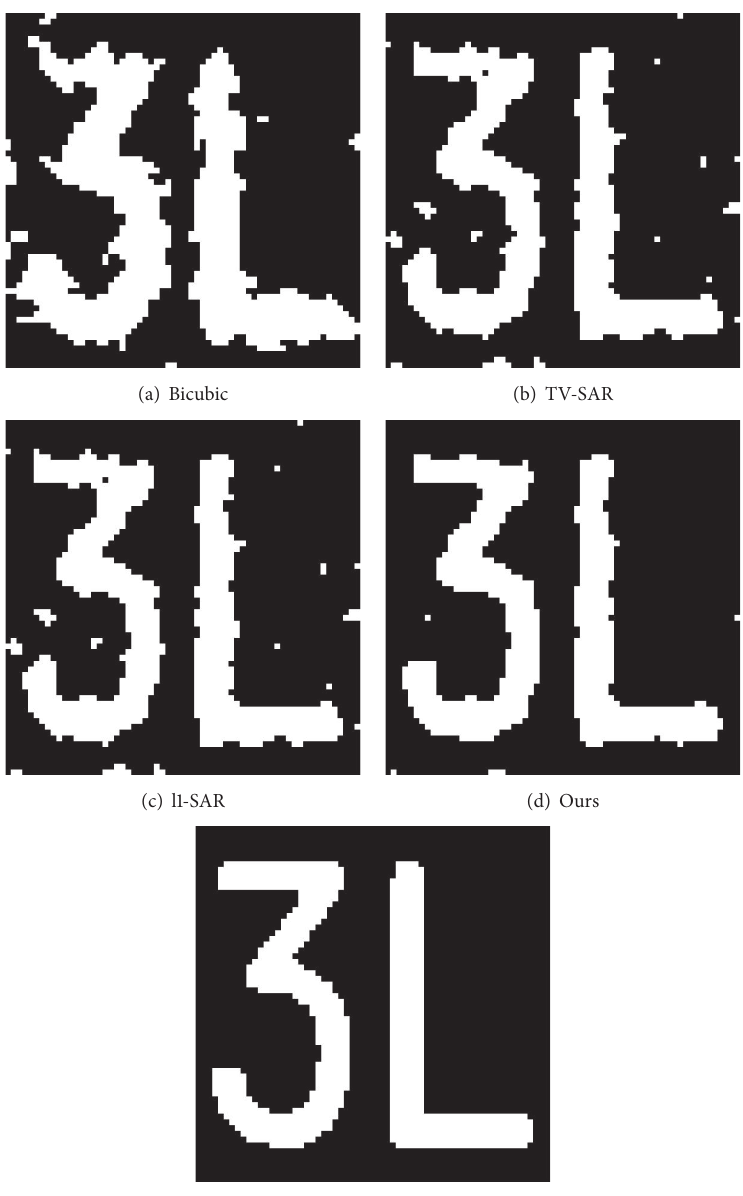
Figure 6: Binary results corresponding to Figure